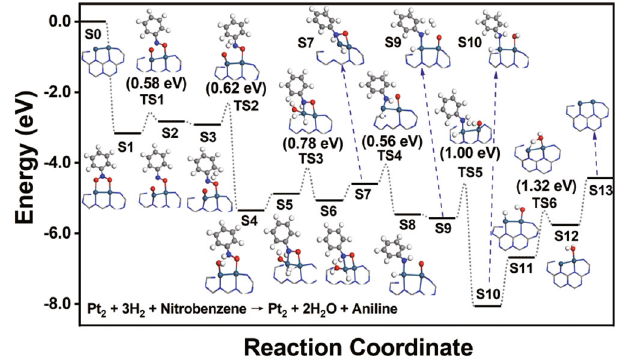
Fig. 4 First-principles calculations of hydrogenation of nitrobenzene on Pt 2 /g-C 3 N4. Reaction pathway and computational energy pro fi le of nitrobenzene hydrogenation on the Pt 2 /g-C 3 N 4 catalyst. The label S0 represents the initial state and the subsequent labels S1 – S12 represent a series of intermediate states. The labels TS1 – TS6 (TS is short for transition states) represent a series of transition states. Here, only the key structures, i.e., the Pt 2 catalytic system, as well as the adsorbate bound on it, are shown. The information regarding reactant molecules which have not been adsorbed, and/or product molecules which have been desorbed are labeled in the Supplementary Information (Supplementary Fig. 24). The teal, gray, blue, red, and white spheres represent the Pt, C, N, O, and H atoms, respectively.